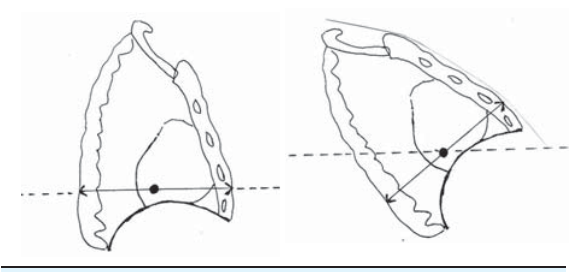
Figure 1. The relation of the anterior end of the fourth intercostal space with the horizontal plane passing through the mid-right atrium in erect and reclining positions Double arrowhead line ( ↔ ) is the anteriorposterior line from the anterior end of the fourth intercostal space to the back with right atrium at the midpoint shown by a central dot. Dotted line (----) is the horizontal plane parallel to the ground passing through the mid-right atrium.